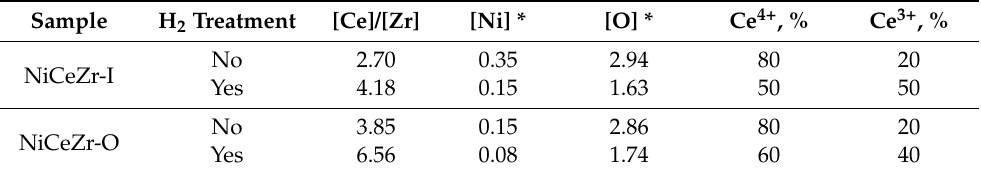
Table 3. XPS data of NiCeZr samples prepared by impregnation and one-pot methods. Sample